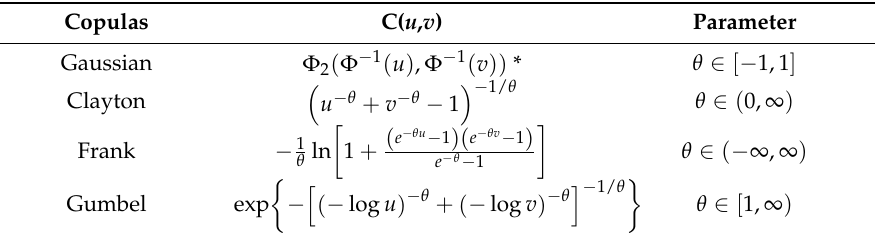
Table 1. Four copulas and their parameter spaces.